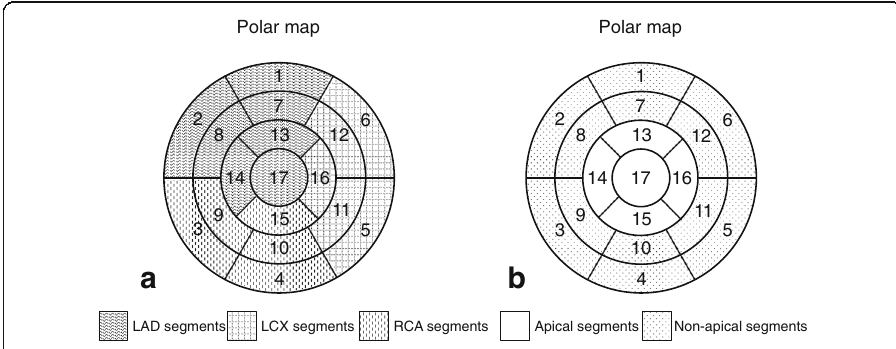
Fig. 2 Left ventricular myocardium polar maps based on 17-segment model. Most standard coronary artery distribution segments ( a ), and apical and non-apical segments ( b